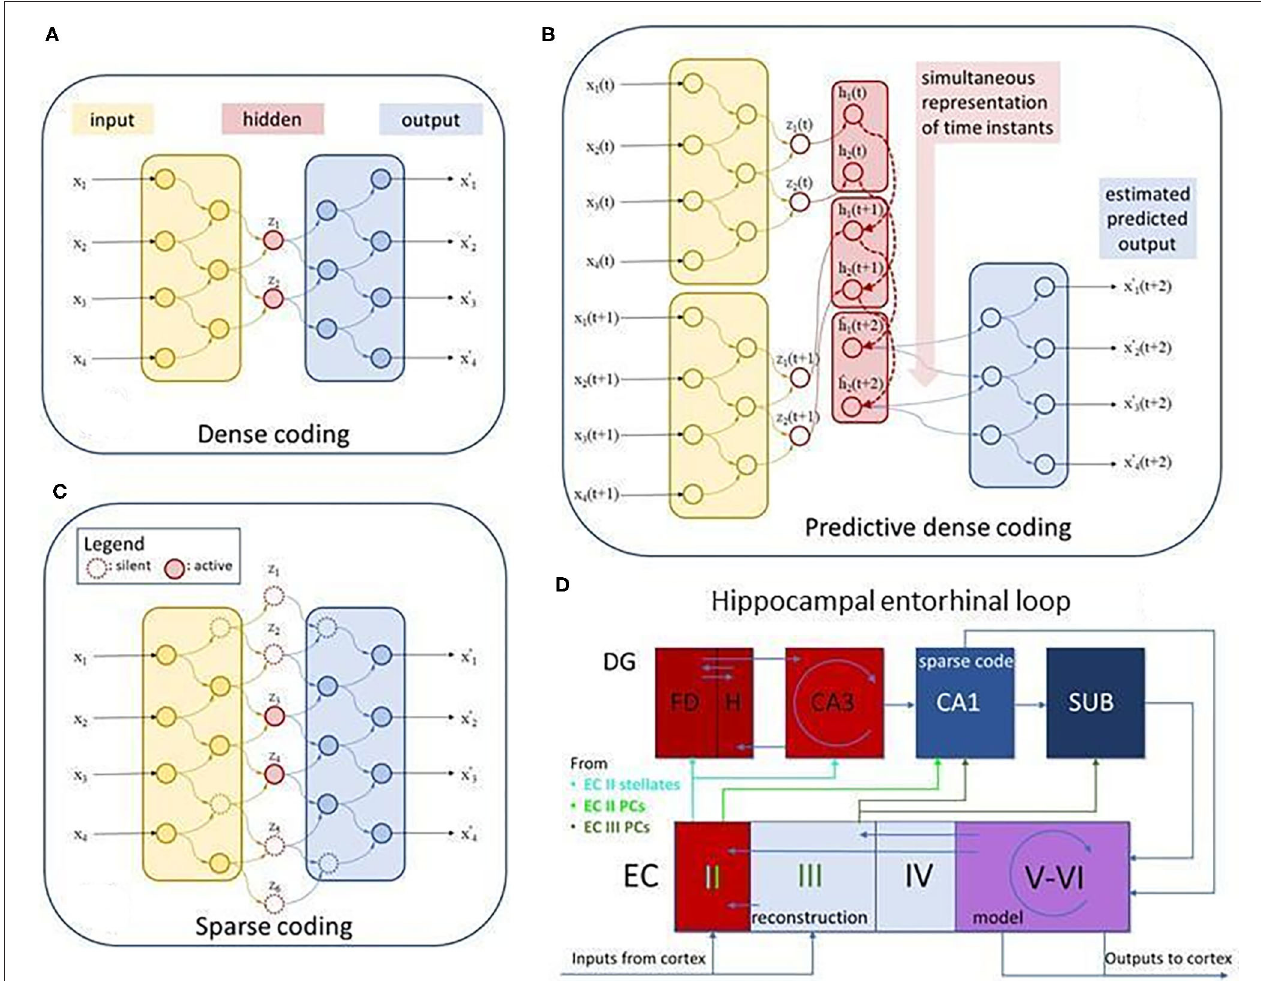
FIGURE 2 | Dense, sparse, predictive dense autoencoders, and the putative autoencoding structure of the entorhinal-hippocampal complex. (A) Dense autoencoder. x: input, z: compressed hidden representation, or code, x-to-z mapping is the encoding process , x ′ : estimated input, z-to-x ′ mapping is the decoding process , (B) predictive dense coding: h: compressed predictive hidden representation. (C) Sparse autoencoder. Same as (A) , but not all units are active at a time. (D) Hippocampal-entorhinal complex: FD, fascia dentate; H, hilus; DG, dentate gyrus; CA1 and CA3, CA1 and CA3 subfields; SUB, subiculum; EC II-III and EC V-VI, superficial and deep layers of the entorhinal cortex, respectively. EC II, putative error layer (e = x–x ′ ); EC III, putative layer for input estimation (x ′ ); EC V-VI, putative predictive model layers (h); Putative role of DG, detecting delays and learning to compensate delays; PC, pyramidal cell. Recurrent connections make a spatio-temporal model from the spatial one, propagate the representation forward in time for upstream estimation of the downstream signal and to compare them to produce errors for correction and for learning. See also Lorincz and Buzsáki (4), Chrobak et al. (5), and Lorincz